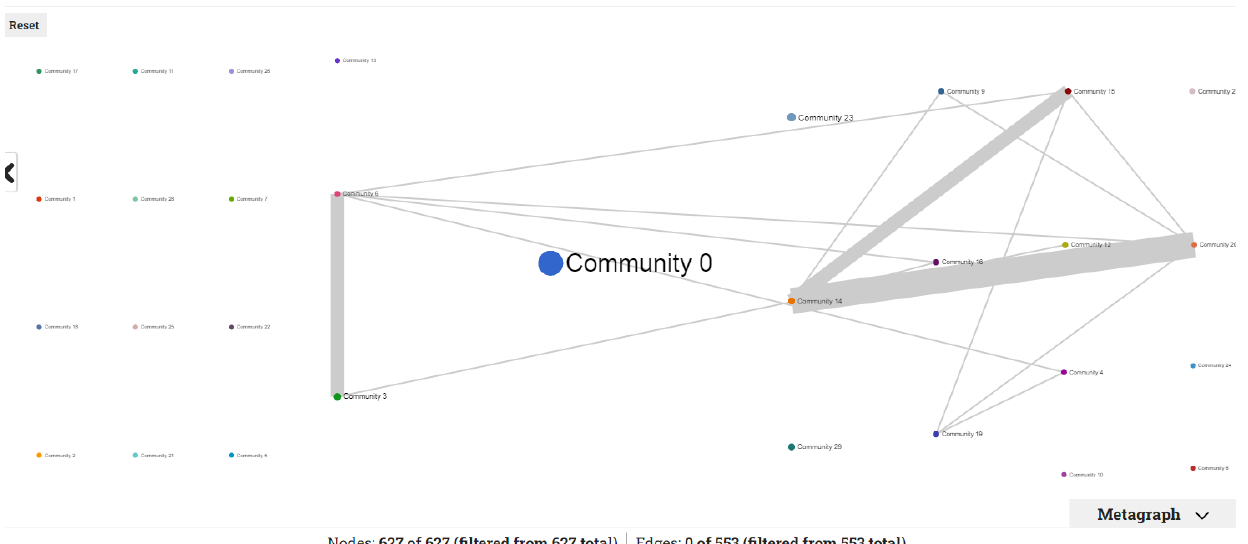
Figure 9. Metagraph showing that the information diffusion in the network was